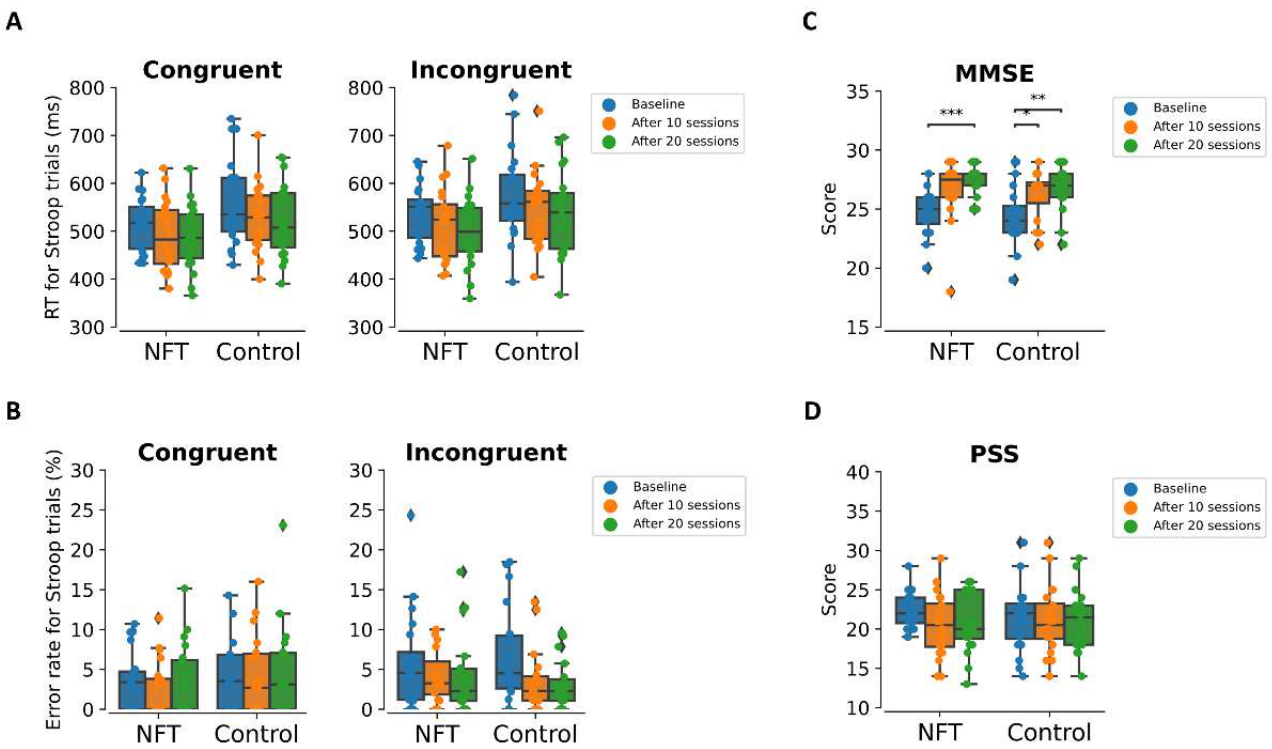
Figure 3. Behavioral results ( A ) RT, ( B ) error rates, ( C ) MMSE, and ( D ) PSS score for NFT and control group at baseline, after 10 sessions, and after 20 sessions. * p < 0.05, ** p < 0.01, *** p < 0.001.